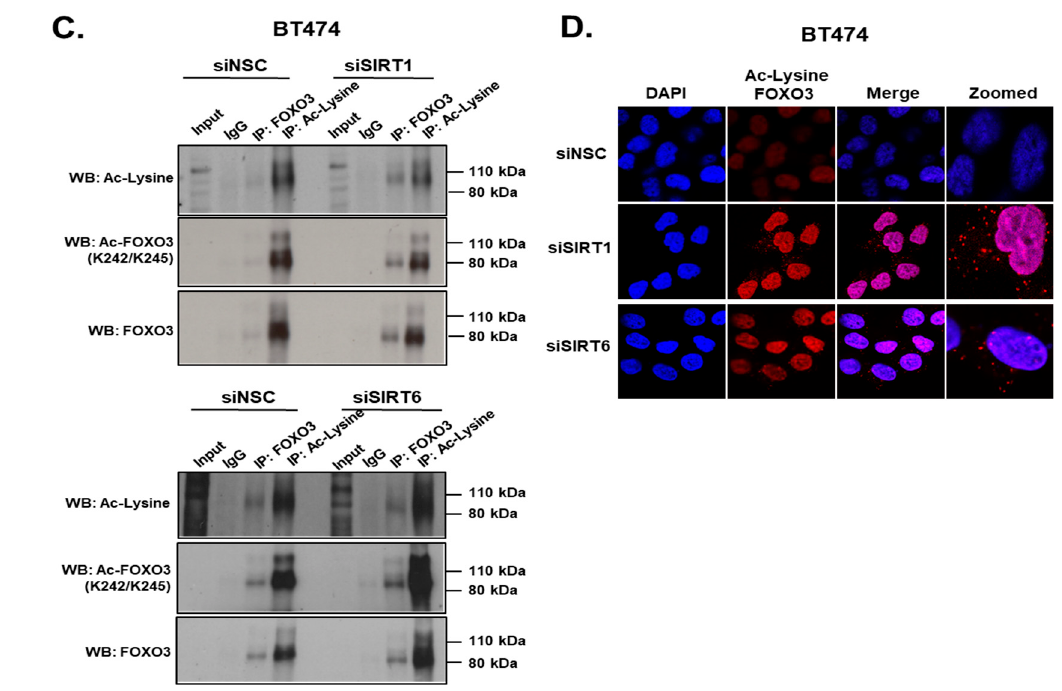
Figure 6. Silencing of SIRT1 and SIRT6 with or without Lapatinib treatment correlates with increased FOXO3 acetylation and its transcriptional activity. ( A , B ) BT474 and BT474 Lap R cells were transfected with Control (siNSC), siSIRT1 or siSIRT6 siRNAs and treated with or without 1 µM Lapatinib for 8 h. After harvesting, protein lysates were obtained and subsequent western blotting was performed to assess FOXO3 acetylation and its transcriptional activity using antibodies against Ac-FOXO3, FOXO3, p27 Kip1 , Bim and others as indicated. The β -tubulin was used as a loading control. ( C ) Co-immunoprecipitation (Co-IP) was performed with anti-FOXO3 and anti-acetylated lysine antibody. Subsequent immunoblotting was performed using antibodies against Ac-Lys, Ac-FOXO3 and FOXO3. The anti-IgG antibody was used as a negative control. ( D ) BT474 and BT474 Lap R cells were transfected with siNSC / siSIRT1 / siSIRT6 siRNAs. After 24 h of transfection, cells were seeded in 8 chamber wells plate. Cells without Ac-Lys and FOXO3 antibodies were used as negative control. Representative confocal images are shown. Cells were visualized with a Leica TCS SP5 confocal microscope equipped with a 63 × oil immersion objective and LAS-AF software. Each red spot represents for a single interaction and DNA was stained with 4,6-diamidino-2-phenyl indole (DAPI) in blue. Scale bar: 10 µ